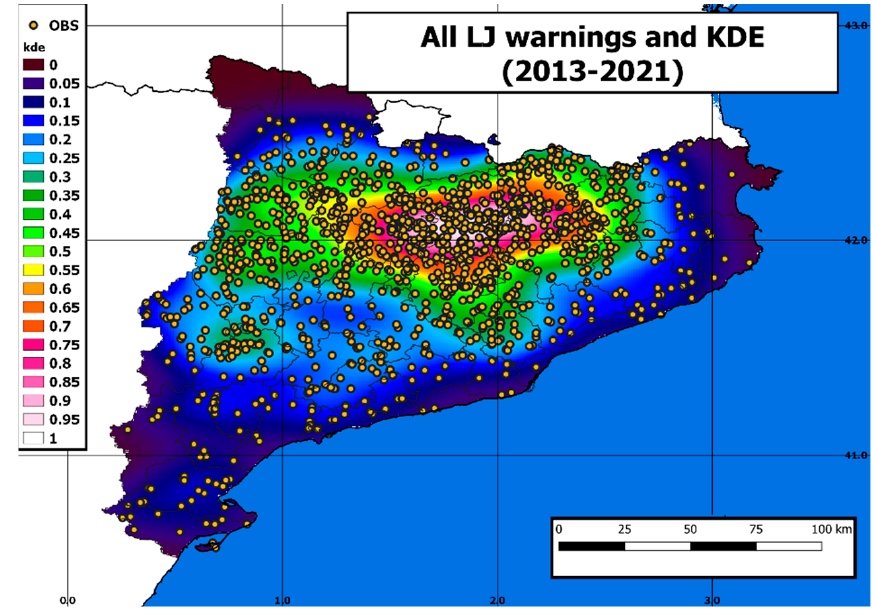
Figure 7. The Kernel Density Estimator field for the Lightning Jumps occurred during the period 2013–2021. Table 2. Correlation values (and the 95% confidence intervals) of the different cumulative Echo Top fields with the different variables: all hail registers (All Obs), severe ( ≥ 2 cm) hail (Sev Obs), large ( ≥ 4 cm) hail (Big Obs), Lightning jump occurrence (LJ), and the topography (TOPO). Variable TOP12 TOP35 TOP45 All